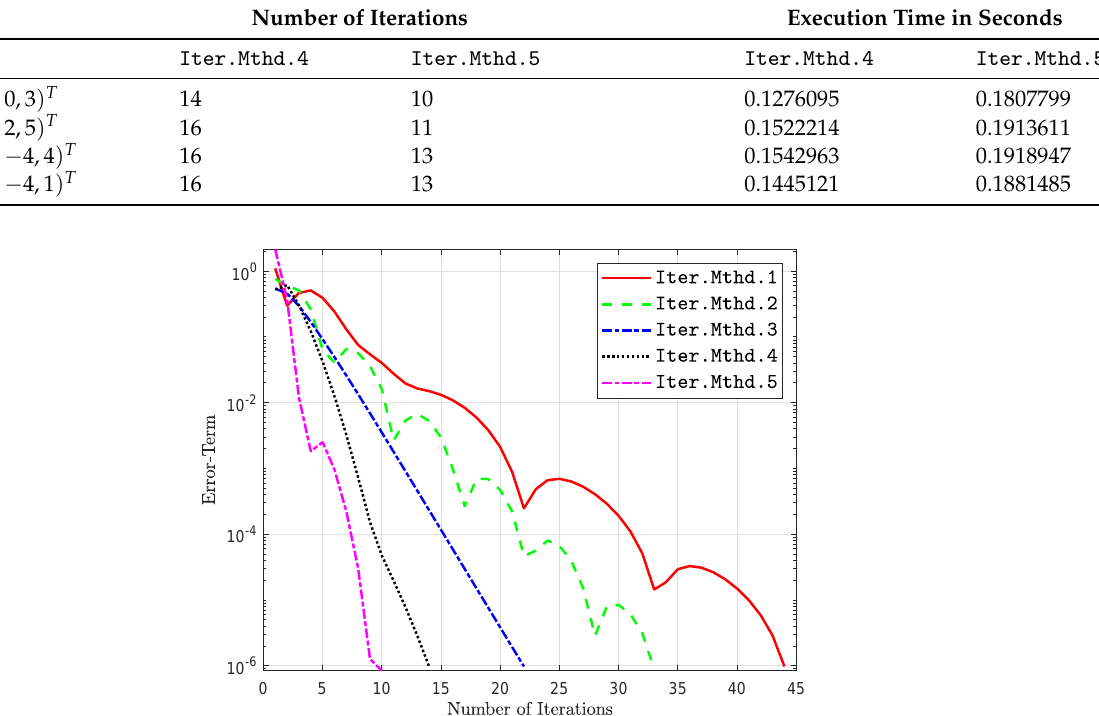
Figure 8. All techniques are computationally examined while s 0 = ( 2, − 2,3, − 4,6 ) T . Table 4. The proposed two techniques have numerical data for Figures 9–16 by using Example 2.